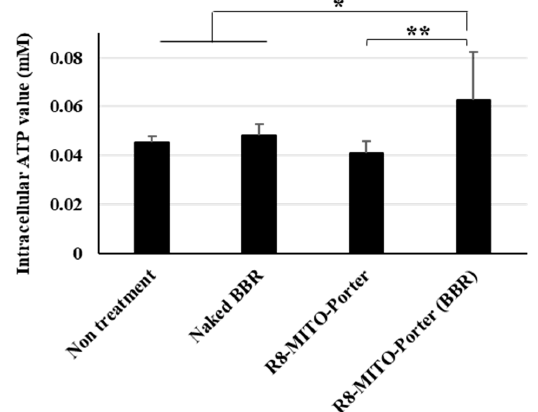
Figure 5. Evaluation of intracellular ATP production. The amount of intracellular ATP was evaluated using an ATP assay kit at 4 h after treatment with these samples. Data are represented as the mean ± S.D. (n = 6). * p < 0.05, ** p < 0.01, one-way ANOVA followed by Student–Newman–Keuls